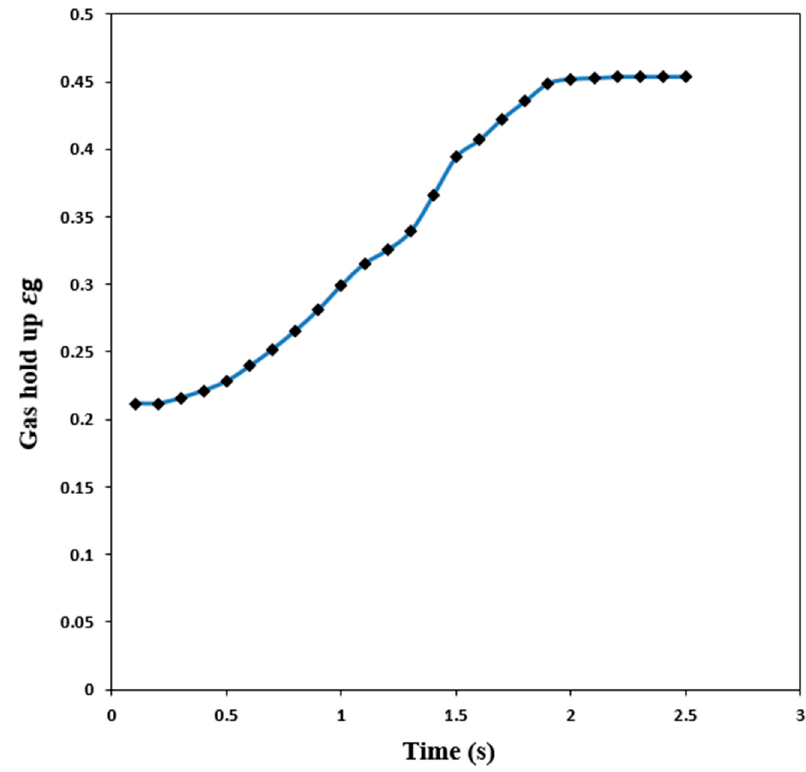
Figure 6. Variation of gas phase hold-up with time at a constant liquid flow rate of 2.17 × 10 − 4 m 3 /s for the air–water system (nozzle diameter = 6 mm).